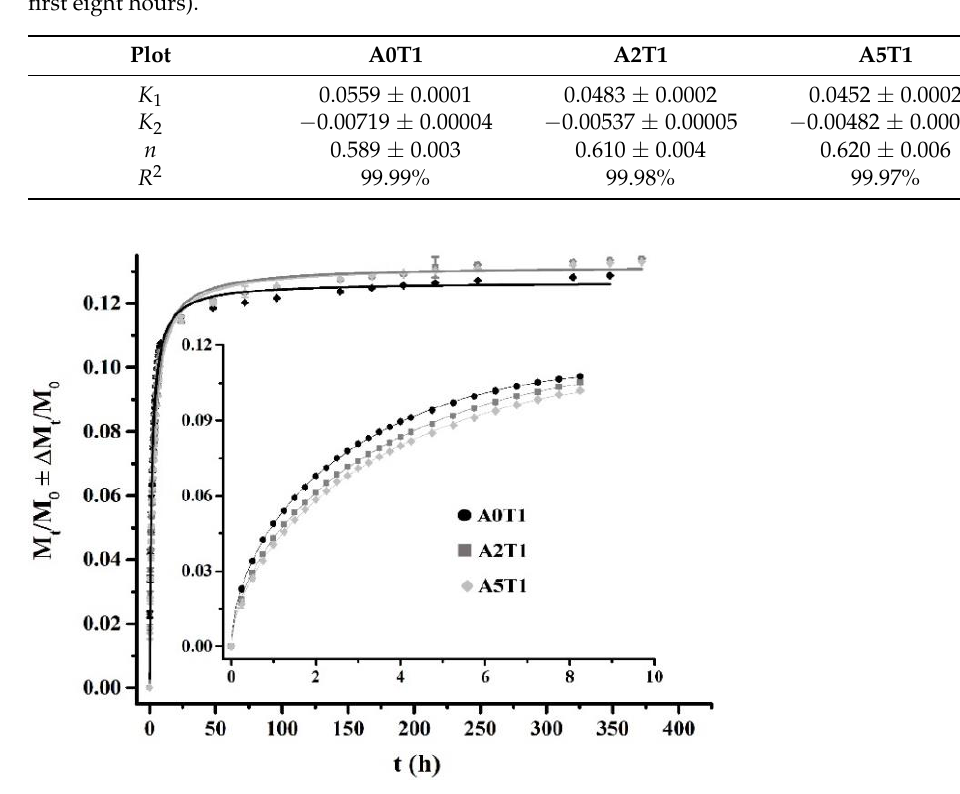
Table 4. Values of the parameters of the logistic curve for each sample (full graphic, Figure 4, 15 days).